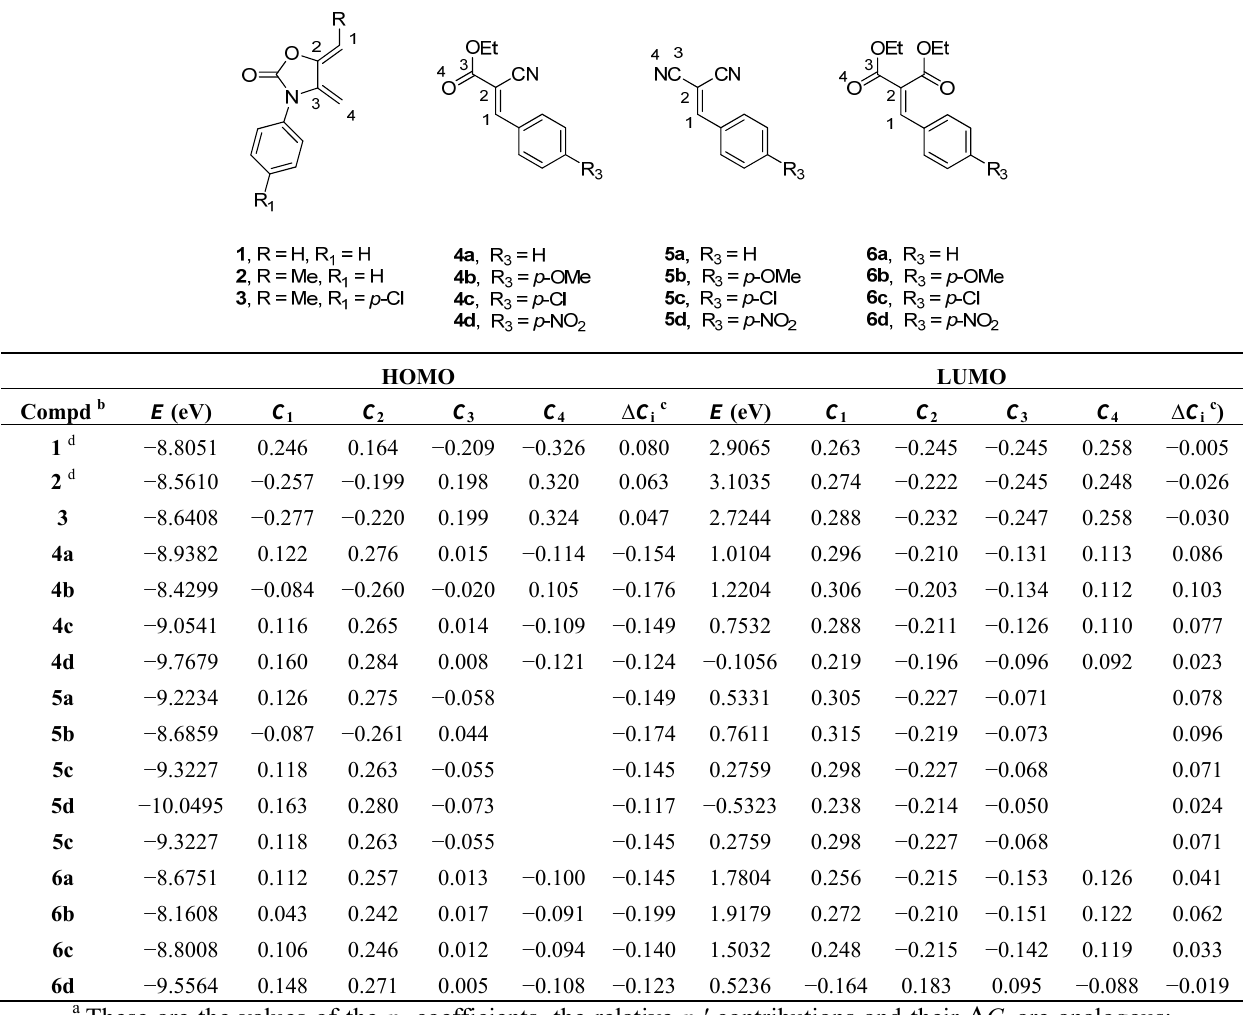
Table 4. Ab initio 6-31G** calculations of energies (eV) and coefficients (C frontier molecular orbitals for dienes 1 – 3 and dienophiles 4 – 6 a